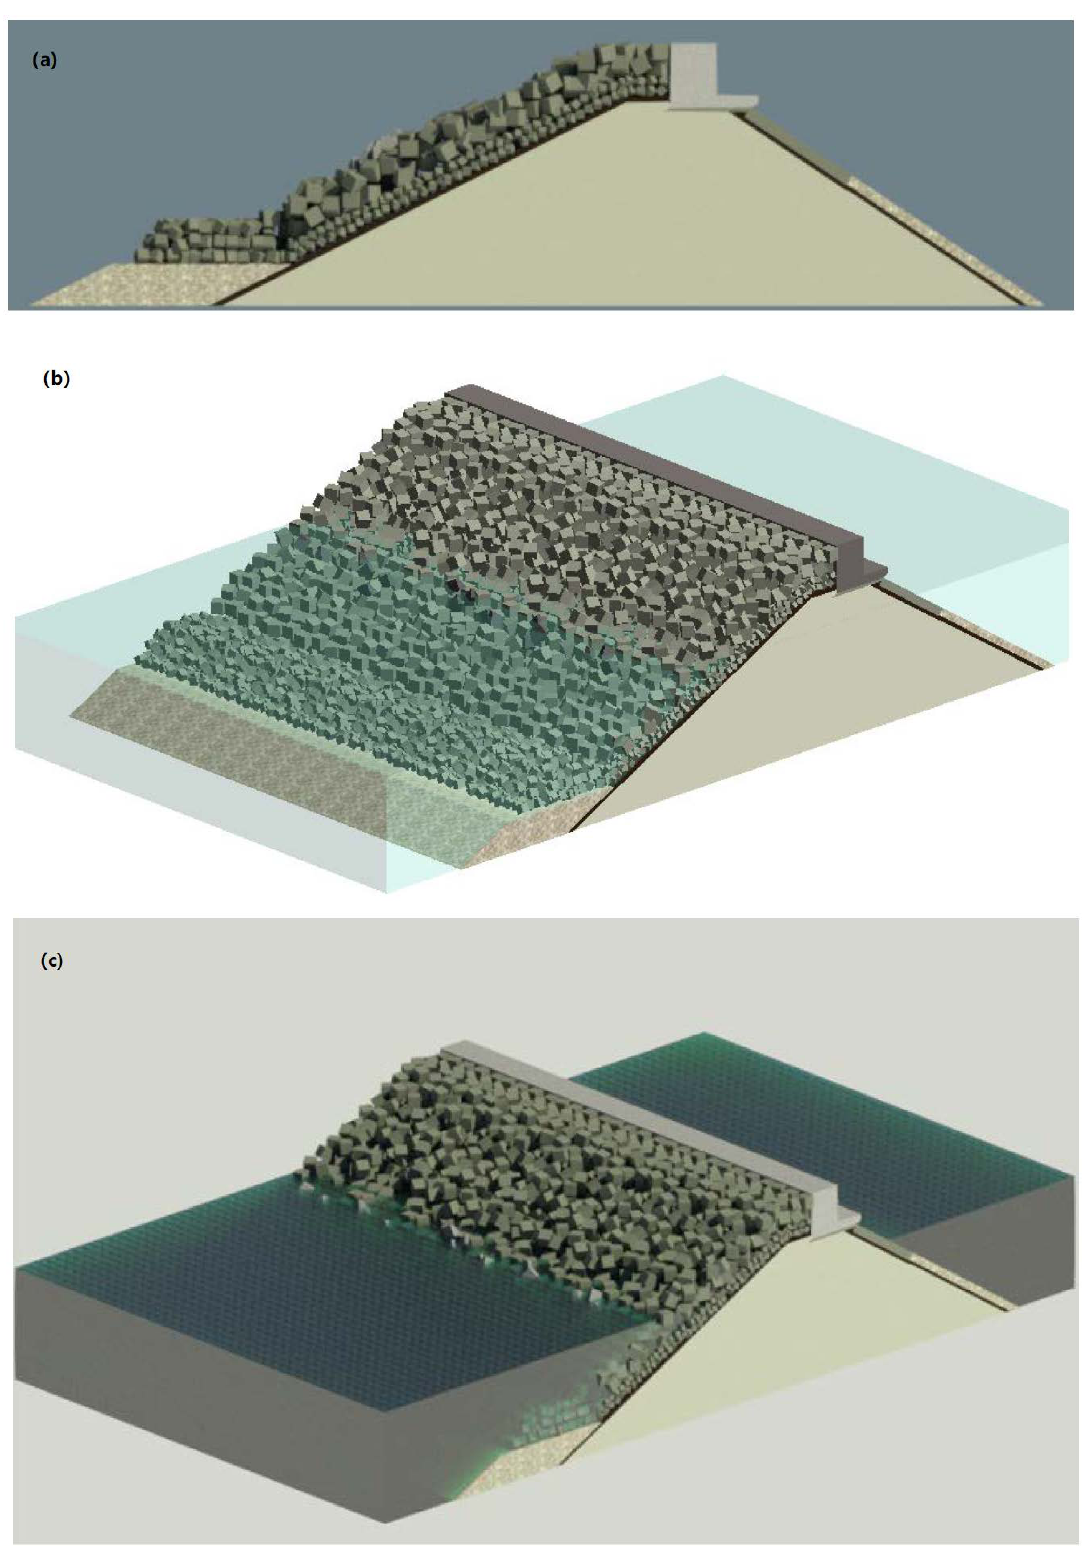
Figure 5. Revit model of the main breakwater of the Outer Port of A Coruña (Langosteira); ( a ) front view; ( b ) diagonal view with transparent sea level; ( c ) diagonal view with non-transparent sea level. In the same way, an 85.5 m section of the spur breakwater was modeled in Revit 2019. Figure 6 shows the hammer plan, and Figure 7 shows the Revit model.